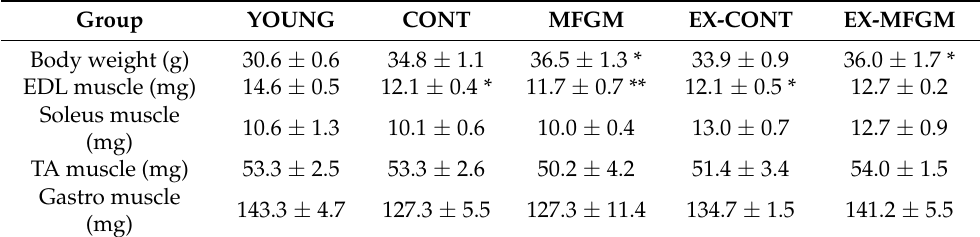
Table 1. Body and muscle weights of BALB/c mice.